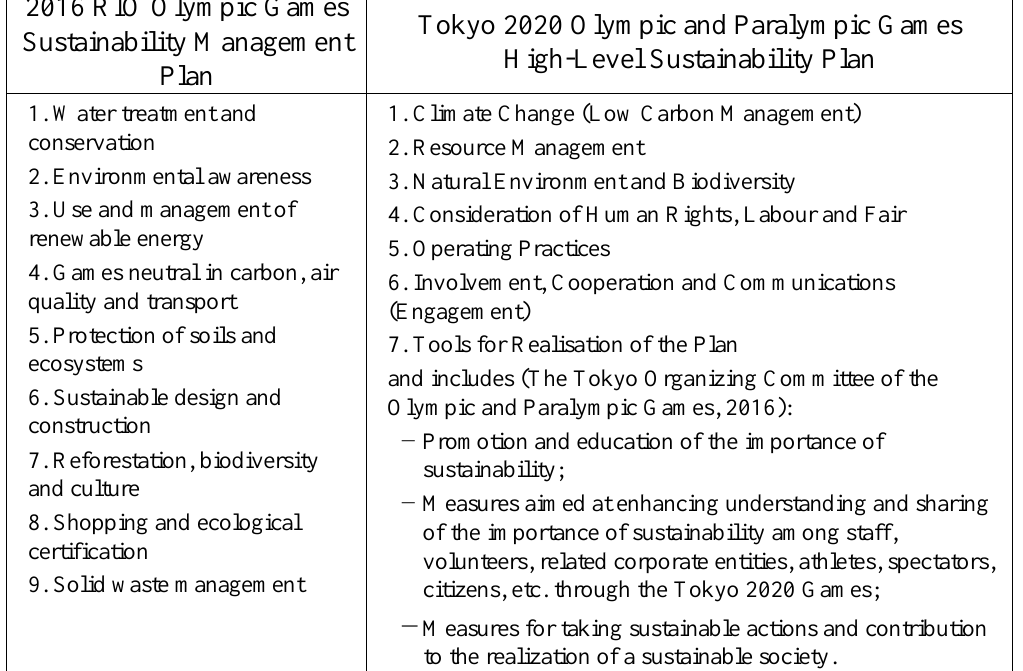
Table 1. Rio Olympic Games Sustainability Management Plan (2013) and Tokyo Olympic and Paralympic Games High-Level Sustainability Plan (The Tokyo Organising Committee of the Olympic and Paralympic Games, 2016) [developed by